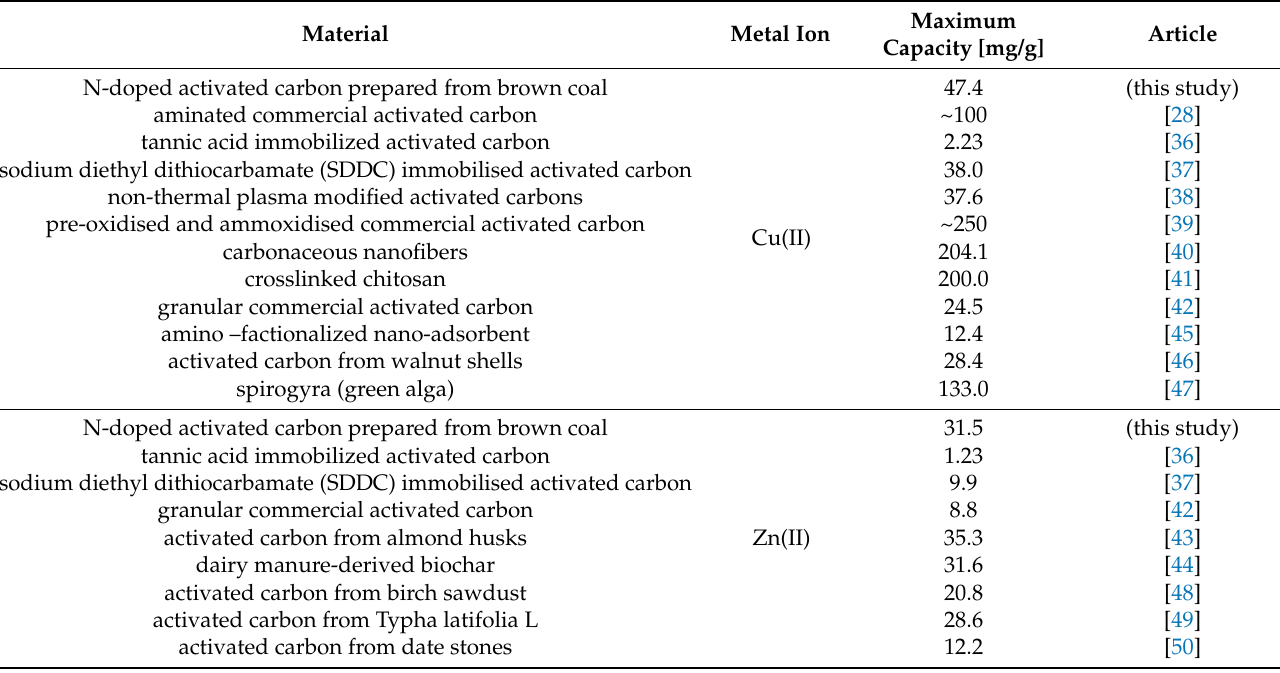
Table 6. Adsorption capacity toward Cu(II) and Zn(II) ions for various carbonaceous materials.